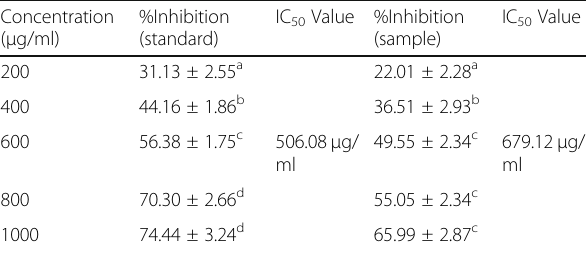
Table 2 Inhibition of Haemoglobin Glycosylation by Chromolaena odorata